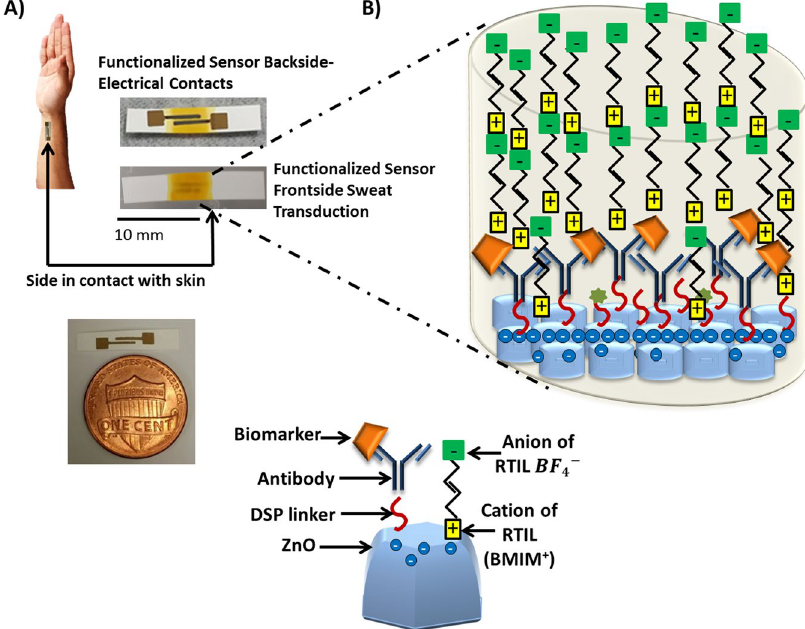
Figure 1. ( A ) Schematic showing our vision of a wearable diagnostic sweat based biosensing and relative size of the developed sensor with RTIL and immunoassay functionalized semiconducting ZnO films on nanoporous polyamide substrates. ( B ) Image showing restricted wicking of fluid in active region of sensor along with a schematic showing capture probe–target biomarker interaction in RTIL and immunoassay with ZnO thin film on a porous membrane within the wicked region of the fluid.